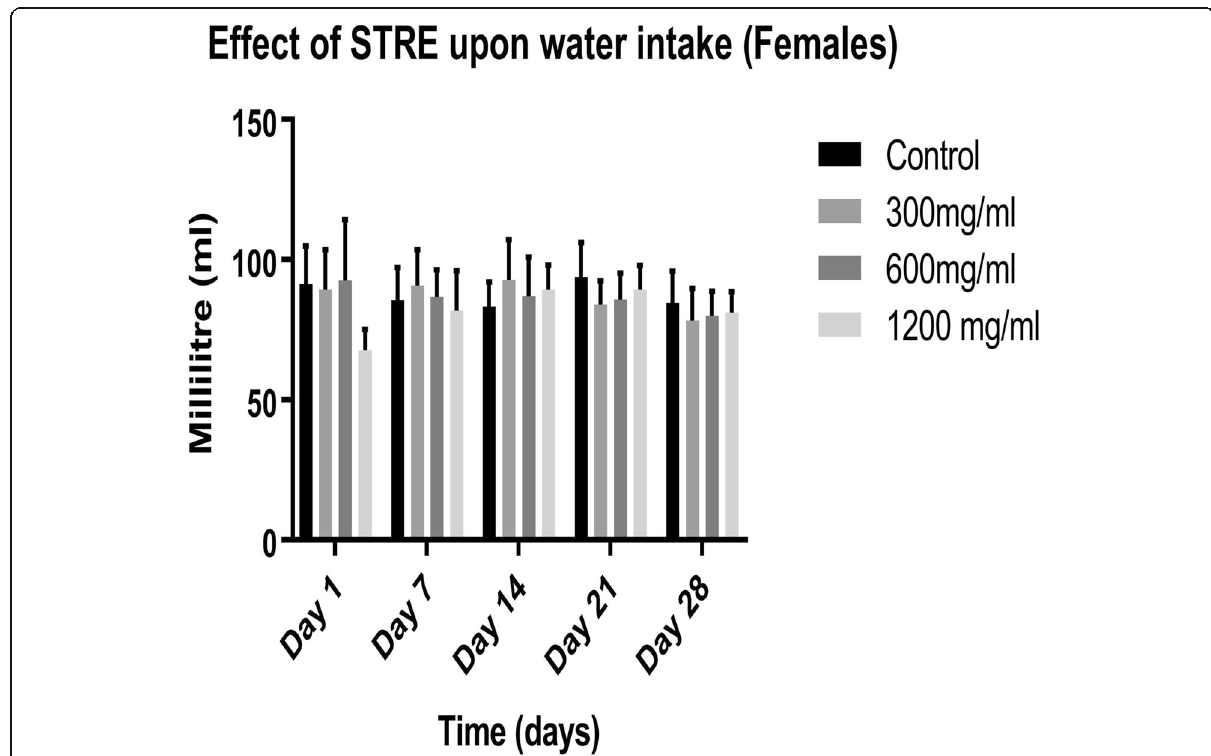
Fig. 8 Effect of STRE on water intake of female subjects. Values are expressed as mean ± SEM Statistical significance (p) calculated by one way ANOVA followed by dunnett ’ s ( n = 6)